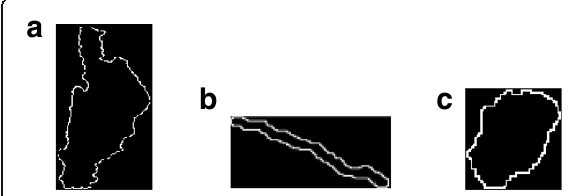
Fig. 9 Rail surface defect profile screenshot. a Defect A. b Defect B. c Defect